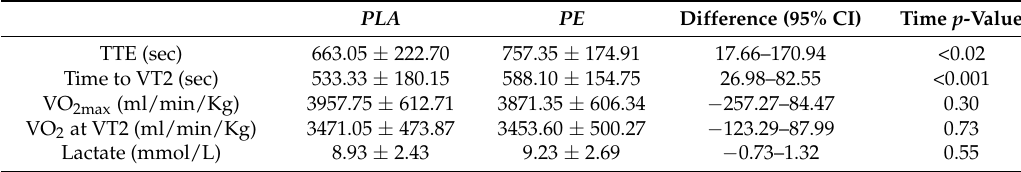
Table 3. Total time to exhaustion (TTE), time to reach ventilatory threshold 2 (time to VT2), maximal oxygen consumption (VO 2max ), oxygen consumption at ventilatory threshold 2 (VO 2 at VT2) and lactate for the IETE. The difference is presented with a 95% confidence interval (CI).